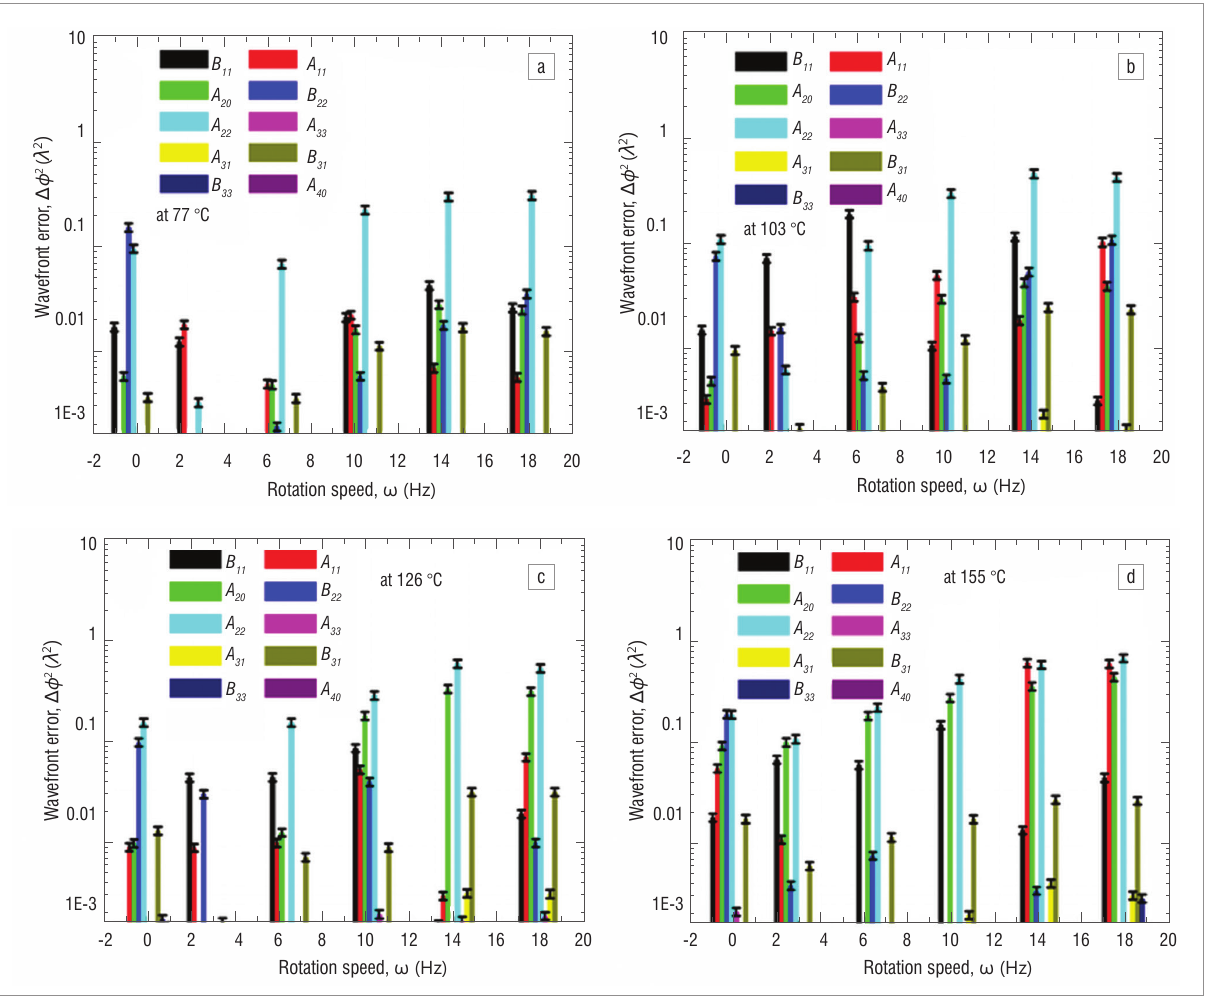
Figure 5: Wavefront error of primary aberration in the spinning pipe gas lens boundary layer at rotation speeds 0 Hz, 2.95 Hz, 6.73 Hz, 10.5 Hz, 14.3 Hz and 18.1 Hz for selected wall temperatures. The Zernike radius was set at 3.71 The average phase maps for the 120–190 frames for each data point determined by each of the selected input parameters are shown in Figure 6, with values on the left for axial propagation and those on the right for the boundary layer. Along the axis, there is a clear distinction among the three flow regimes – the natural, the mixed, and then the forced convections. The blue part of the phase indicates less of a phase delay than the red part. The natural convection is shown in the small top left- hand corner of the grid, the forced convection in the larger bottom right- hand corner and the mixed convection stretches diagonally in-between (Figure 6a). Under natural convection, the beam is slightly diverging with a fair amount of tilt as the centre of the phase patterns is located slightly lower than the centre of the aperture. At the onset of forced convection, the phase is dominated by negative defocus as the laser beam is focused with the tilt totally removed, especially at the highest rotation speed and wall temperature. The transition between the two convection states also occurs at lower rotation speeds and lower temperatures as the wall temperature increases. In the boundary layer there is a density gradient because of the GRIN effect, which tilts the beam as either rotation speed or temperature increase (Figure 6b). At 53 °C, rotating the pipe results in a significant temperature difference, which causes gas exchange with the environment and creates density variations, and so phase changes to the beam wavefront. The phase map, in fact, begins to stretch out, losing rotational symmetry. This asymmetry becomes observable at 10.5 Hz. At higher wall temperatures, the effect becomes observable at lower rotation speeds. At the highest rotation speeds, at all temperatures, we